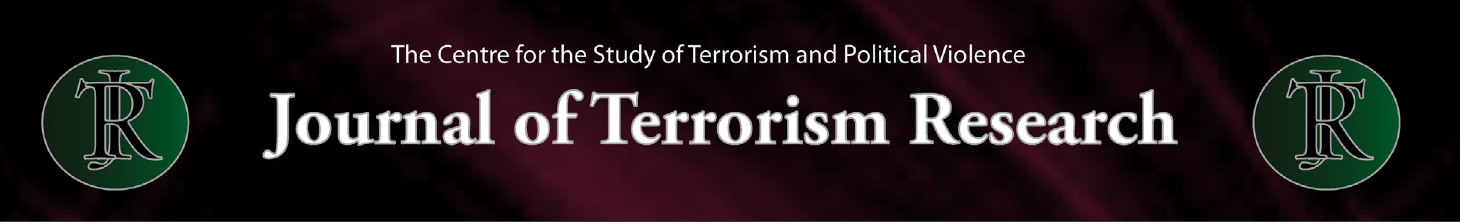
Table 3: Persuasive devices used by Al Qaida, its Affiliates and Associates on the Internet Persuasive